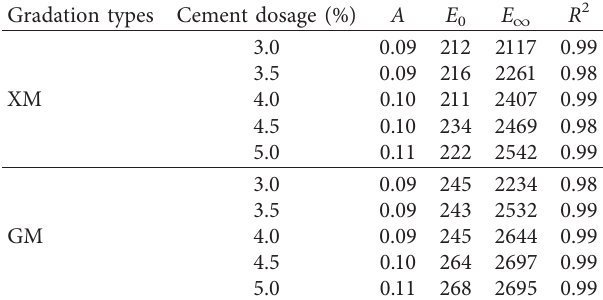
Table 8: Parameters of growth equation of compression modulus of resilience of CSCG.